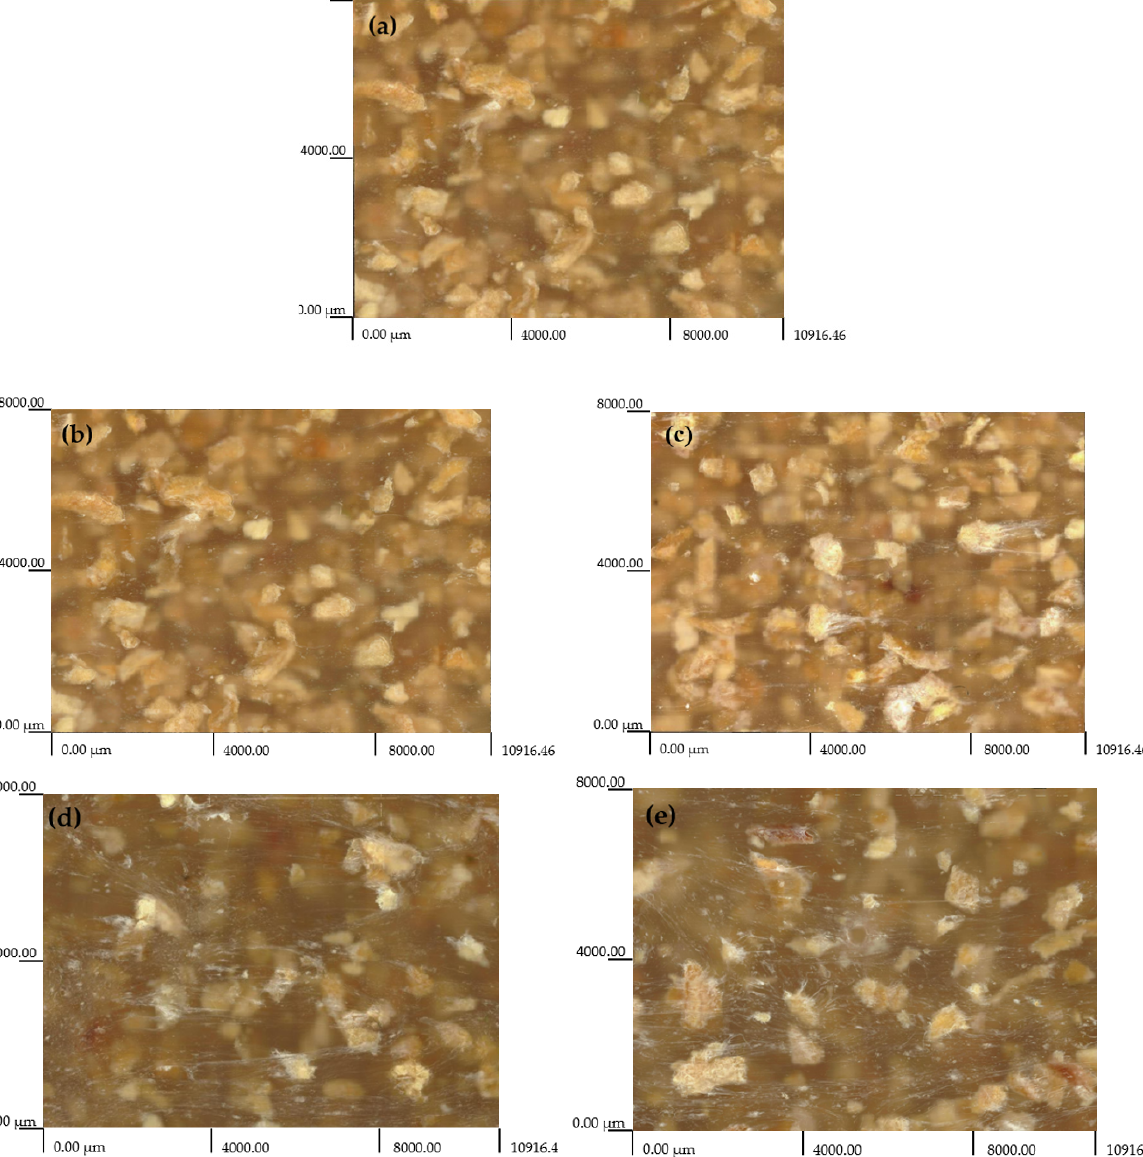
Figure 9. Microphotographs of polymer composite samples containing 20 wt% natural filler, i.e., pumpkin seed hulls with grain sizes of 0.6–0.8 mm (the samples are shown before and after